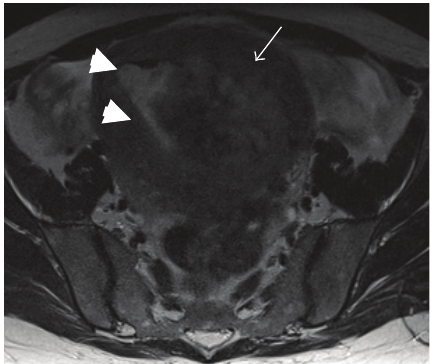
Figure 2: T2-weighted axial MRI image of the pelvis showing the large heterogeneous left intramural uterine mass (white arrow) encroaching into the uterine cavity (white